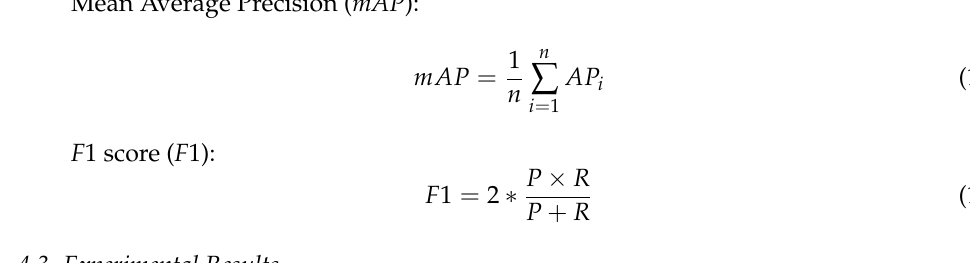
Figure 9. Loss function diagram.